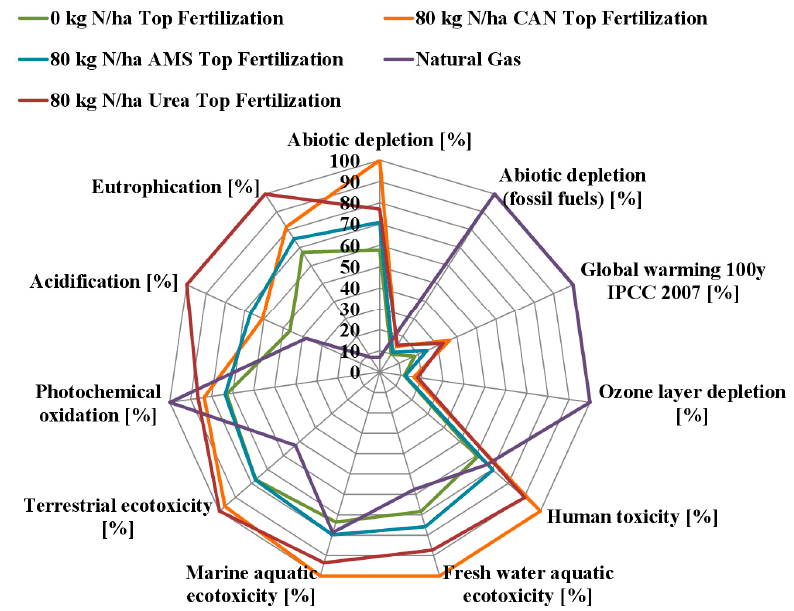
Figure A2. Corner-Middle-Layer (CML) method impacts derived from the life cycle assessment of natural gas and from the life cycle assessment of rye energy crops grown under four different fertilizer regimes to produce electricity. NUL: none top fertilization, AMS: ammonium sulphate, CAN: calcium ammonium nitrate, URE: urea.